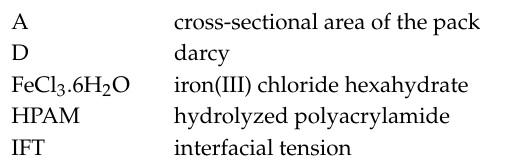
Table S1: Average particle size measurement using